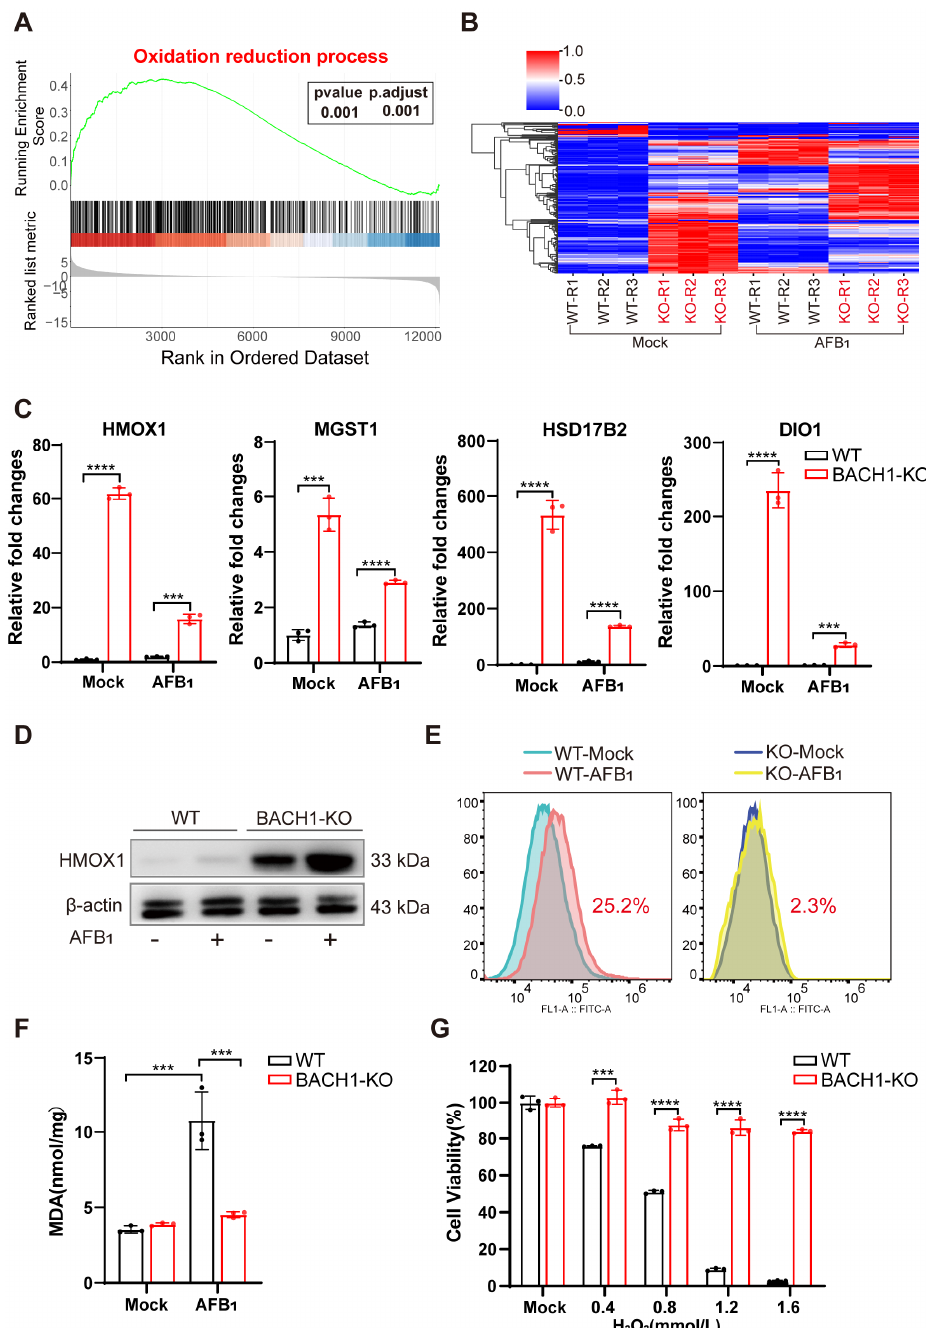
Figure 3. BACH1 deficiency attenuates oxidative damage from AFB 1 via upregulation of antioxidant factors. ( A ) Gene set enrichment analysis (GSEA) identified the oxidation–reduction process as signifi- cantly enriched with differentially upregulated genes in RNA-Seq data of BACH1-KO cells treated with AFB 1 . ( B ) Heatmap of the relative expression levels of genes in the core enrichment subset of GSEA. ( C ) qPCR validation of RNA-Seq data showing differential mRNA expression of antioxidant genes in oxidation reduction. ( D ) Western blot analysis of HMOX1 in WT and BACH1-KO cells with and without AFB 1 exposure. ( E ) BACH1-KO cells exhibit lower levels of AFB 1 -induced ROS. ( F ) Comparison of MDA levels induced by AFB 1 in WT and BACH1-KO cells. ( G ) H 2 O 2 -induced cell death in WT and BACH1-KO cells. *** p < 0.001, **** p < 0.0001. p values were determined with two-tailed Student’s t -tests. AFB 1 , aflatoxin B 1 ; WT, wild-type; KO, knockout; RT-qPCR, Real-time quantitative